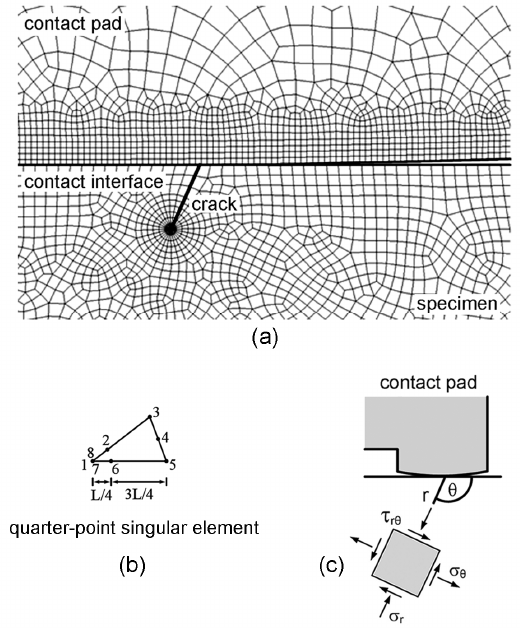
Figure 13. ( a ) FEA model for the determination of fatigue crack path; ( b ) element type at crack tip; and ( c ) polar coordinate at contact.